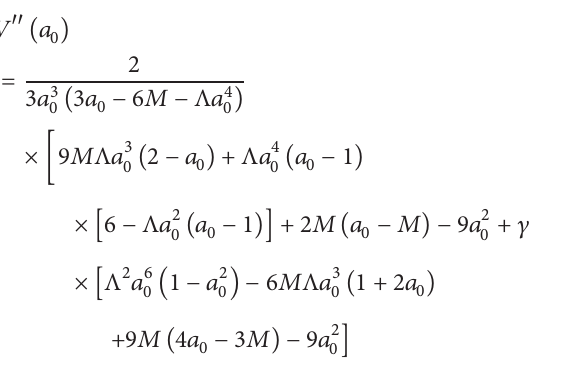
By substituting 𝐺(𝑎) and 𝐺 󸀠 (𝑎) in (34), 𝑉 󸀠󸀠 (𝑎 0 ) (satisfied by the throat radius) turns out to